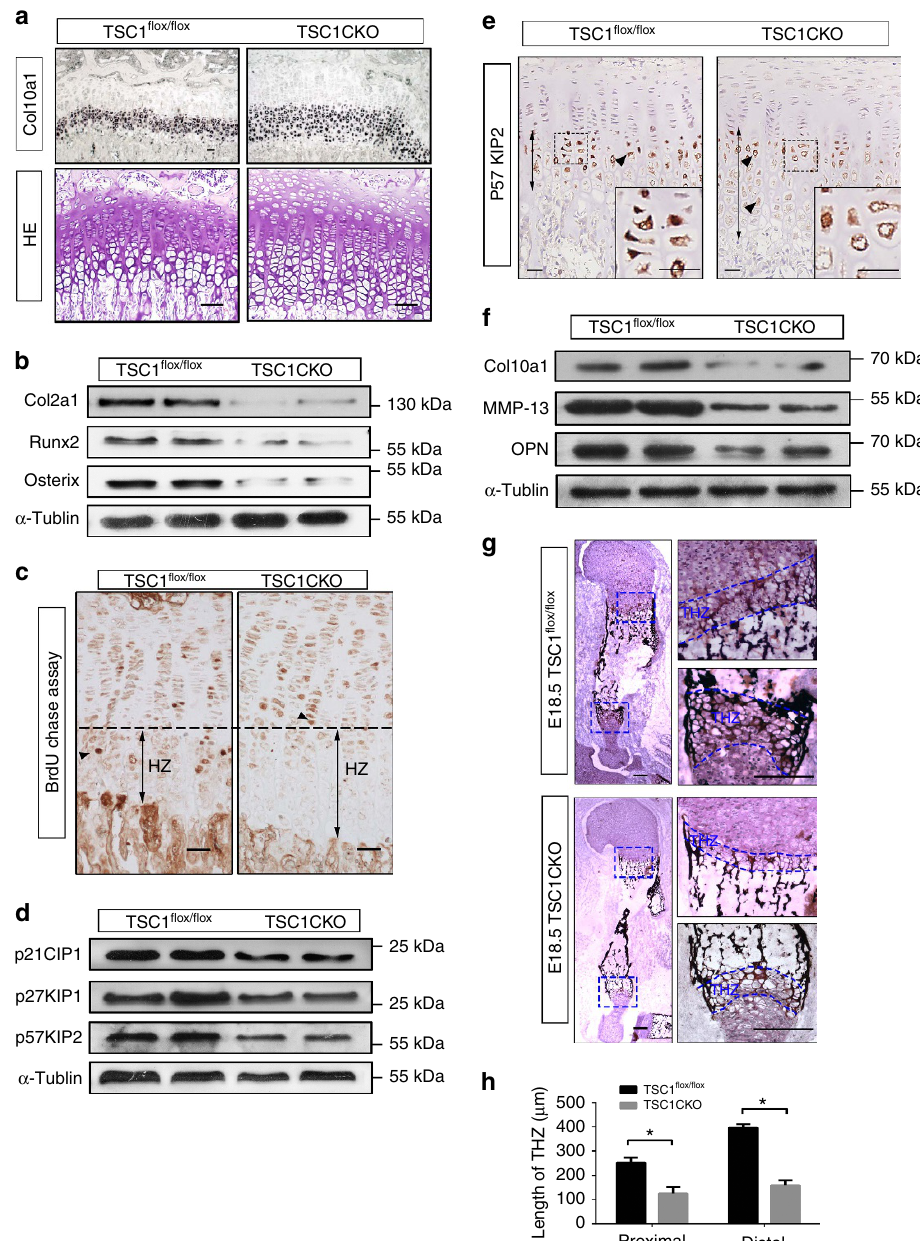
Figure 5 | mTORC1 activation inhibits hypertrophic terminal differentiation and ossification. ( a ) In situ hybridization analysis of Col10a1 mRNA and HE staining in TSC1CKO and control mouse tibia at 3 weeks. Scale bar, 100 m m. ( b ) Western blot showing the expression of Col2 a 1, Runx2 and Osterix in epiphyseal cartilage harvested from 4-week-old TSC1CKO and control mouse tibia. ( c ) BrdU immunohistochemical analysis of tibia from TSC1CKO mouse at 2 weeks after 2 days of BrdU chase assay. The line indicates where differentiation begins. Triangles signify the most distal BrdU-positive chondrocytes. Scale bar, 100 m m. ( d , e ) Western blot analysis of p57KIP2, p21CIP1, p27KIP1 ( d ) and immunohistochemical analysis of p57KIP2 ( e ) in tibia of 4-week-old TSC1CKO and control mice. Black triangles show the p57KIP2-positive cells, the arrow lines show the area chondrocytes expressed p57KIP2. Boxed area at the lower right corner represents higher magnification. Scale bar, 100 m m. ( f ) Western blot analysis showing the expression of MMP-13 and OPN in epiphyseal cartilage harvested from 4-week-old TSC1CKO and control mouse tibia. ( g ) Von Kossa staining was performed on the frozen sections of humerus from TSC1CKO and control mice at E18.5. Boxed areas signify terminal hypertrophic chondrocytes undergoing ossification. THZ, terminal hypertrophic chondrocytes zone. Scale bar, 200 m m. ( h ) Graph represents quantification of the width of THZ in TSC1CKO and control mice. Student’s t -test, * P o 0.05, n Z 3; Error bars indicate of mTORC1 signalling on protein synthesis (Fig. 7i). Moreover, proliferation of chondrocytes from TSC1CKO mice (Fig. 7j,k). although both a Gli1/2 inhibitor, GANT-61 and a IHH Accordingly, rapamycin, but not GDC-0449 reduced Gli1, receptor smoothened (SMO) antagonist, GDC-0449, repressed Patched1 and PTHrP expression in TSC1 null chondrocytes proliferation of primary cultured chondrocytes from WT mice, (Fig. 7l). Importantly, chromatin immunoprecipitation (ChIP) only the Gli1/2 inhibitor, but not the SMO agonist, inhibited the assay further confirmed the mTORC1-dependent binding of Gli2